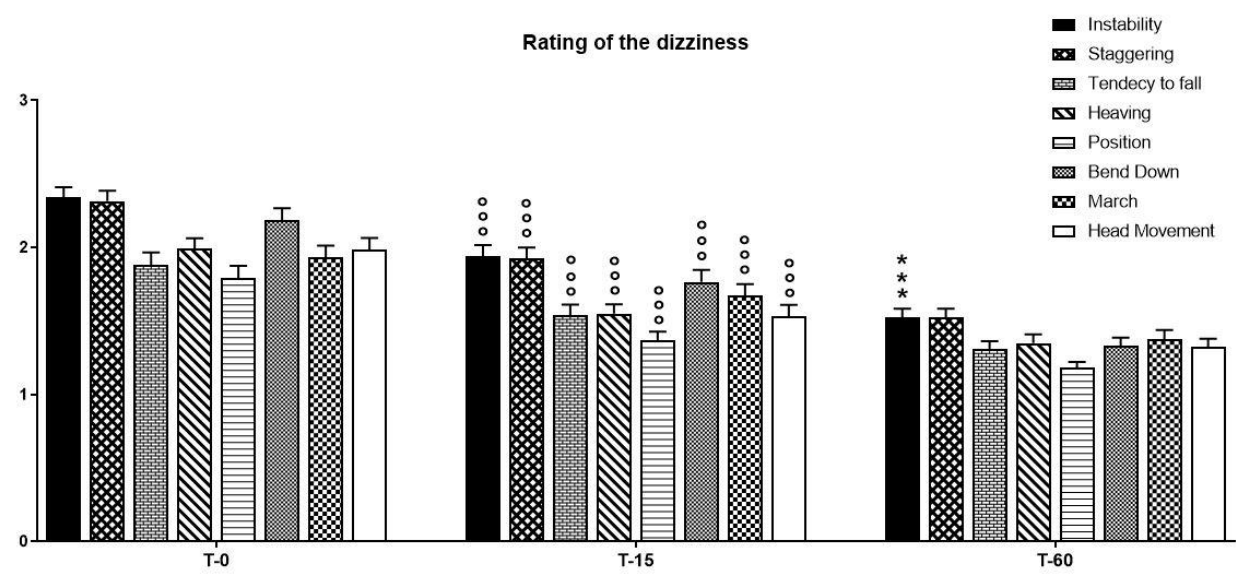
Figure 4. The intensity of vertigo and concomitant symptoms, as evaluated by the five-point verbal rating (or visual analogue) scale—ranging from no vertigo (0) to rarely (1), occasionally (2), frequently (3), and continuously (4)—has been taken into account in order to assess the efficacy of treatment with a fixed-combination preparation of cinnarizine (20 mg) plus dimenhydrinate (40 mg) on the reduction of the triggering factors of the dizziness itself. Data refer to n = 120 patients, and are represented as the mean ±SD of the factors able to trigger vertigo. *** p < 0.001 vs. T15; °°° p < 0.001 vs. T0. T0: baseline; T15: evaluation after 15 days from the start of therapy; T60: evaluation at the end of therapy .